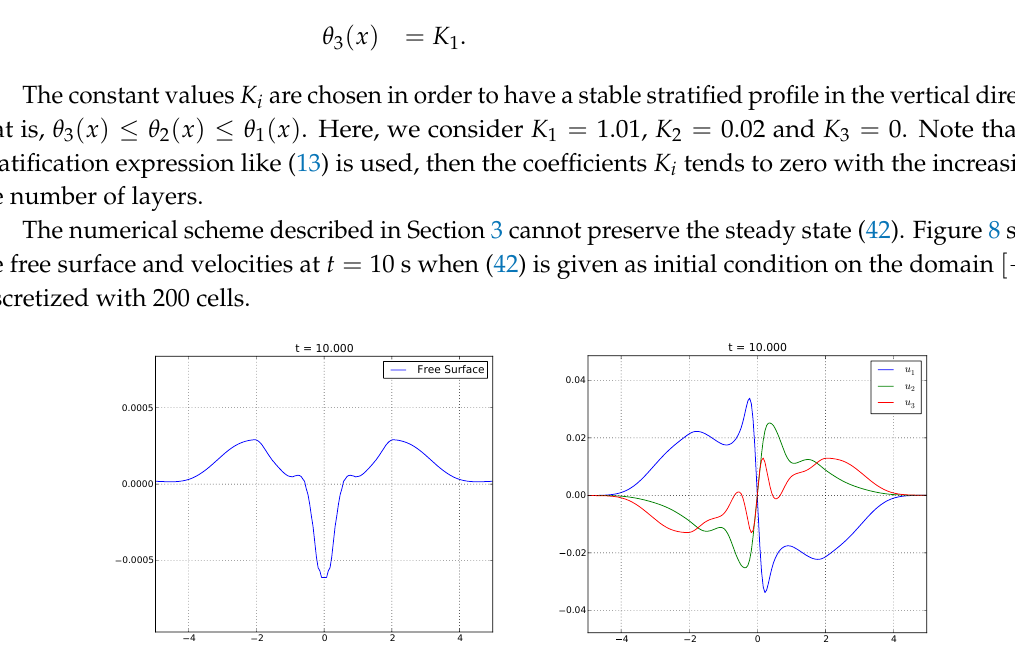
Figure 8. Free surface ( left ) and velocities ( right ) at time t = 10 s: solution obtained with the numerical scheme